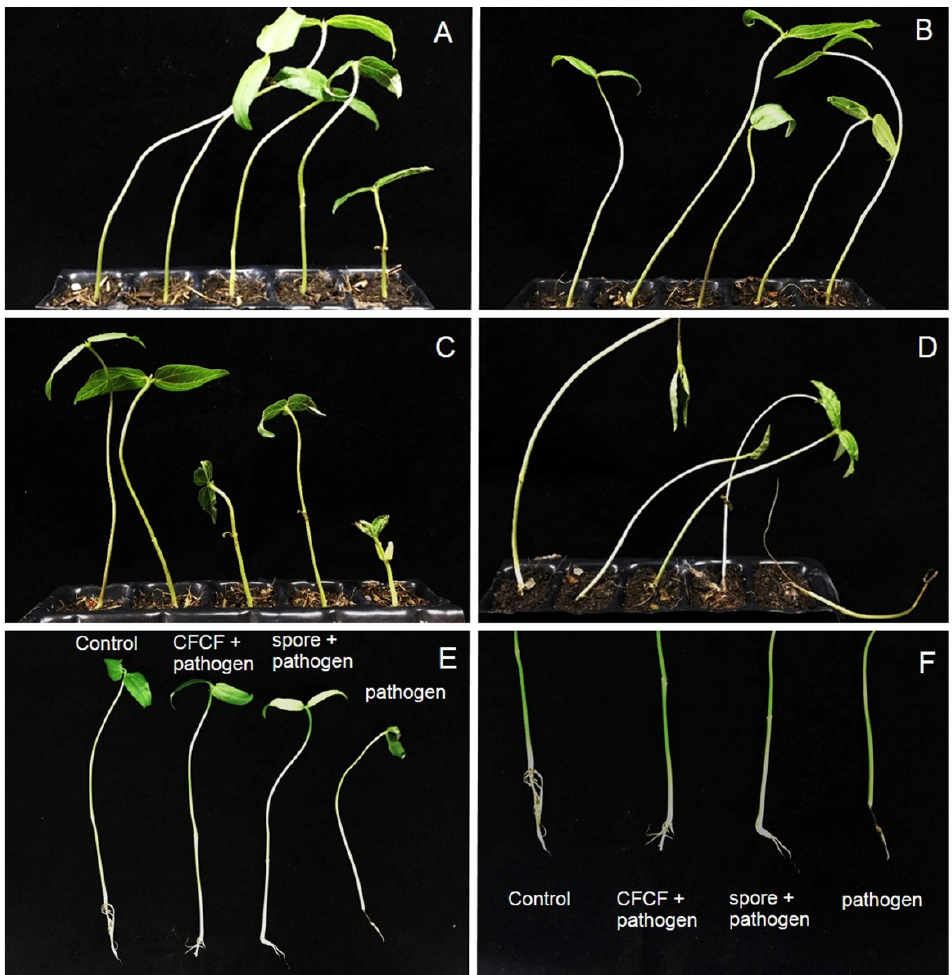
Figure 5. In planta test of the cell-free culture filtrate (CFCF), and the spore suspension of Streptomyces Z1-04-02, to combat sclerotium rot in mungbean seedlings: treatment with distilled water ( A ), CFCF ( B ), spore suspension ( C ), Sclerotium rolfsii only ( D ), symptom development in the mungbean plant ( E ), and a zoomed-in view of symptoms ( F ).